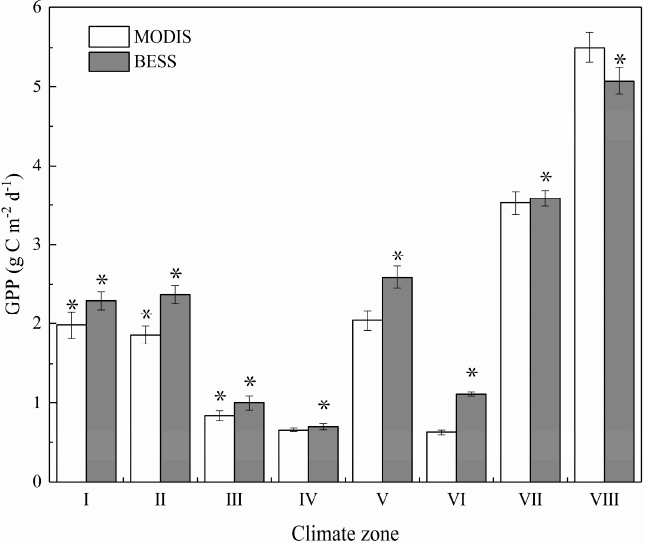
Figure 3. Comparison of multiyear mean MODIS and BESS GPP over the eight climate zones in China from 2001 to 2015. Error bars represent ±1 standard error. The asterisks mean significantly different for GPP values in 2001–2015 ( p < 0.05).